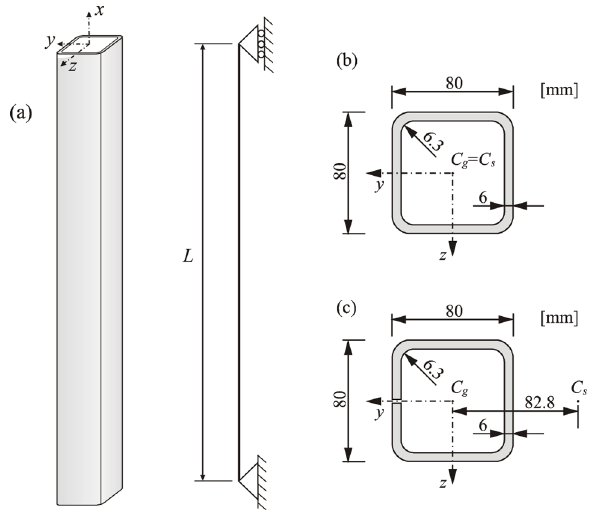
Fig. 1. Column with square cross-sections